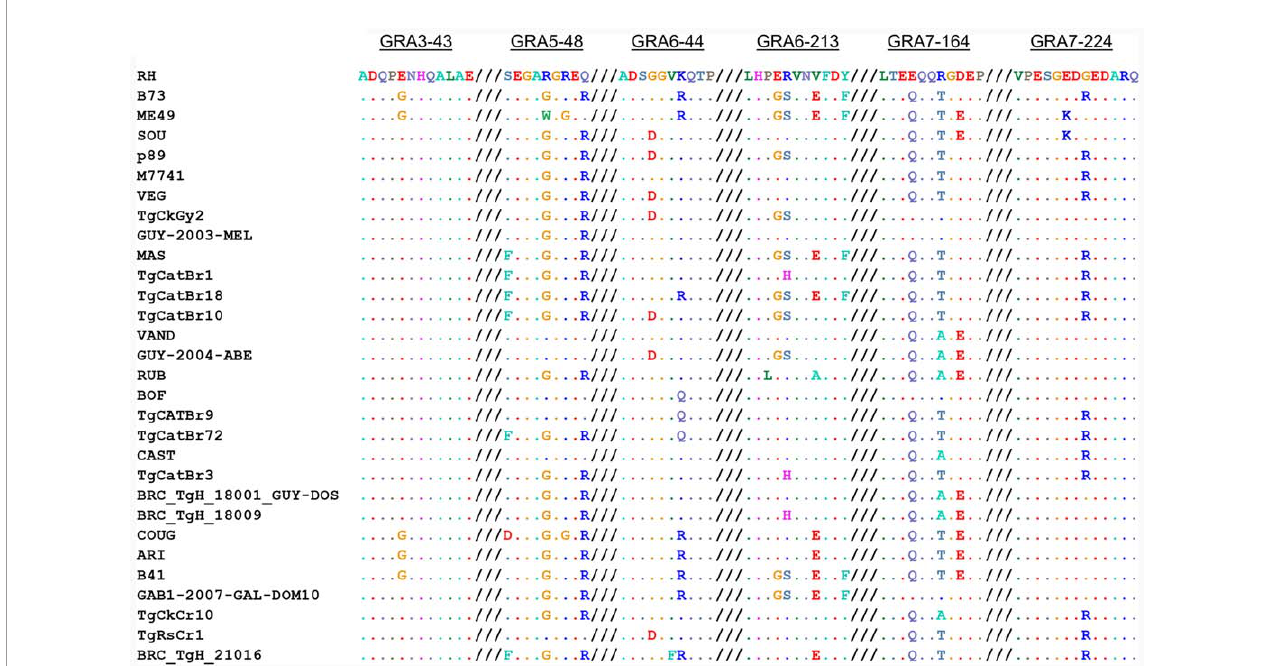
FIGURE 5 | Allele combinations in GRA peptide amino acid sequences among 64 Toxoplasma strains. Amino acid sequence alignment from GRA3-43, GRA5-38, GRA6-44, GRA6-213, GRA7-164 and GRA7-224 peptides (from left to right, respectively) in the 64 strains available on ToxoDB shows the possible combinations that give rise to different allele groups. The different possible combinations are aligned and a representative strain from each group is given, where dots indicate identical amino acids. For further details and individual sequences for each strain we refer readers to Supplemental File 5